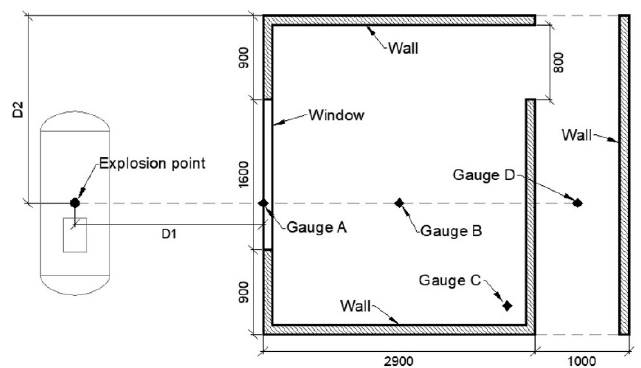
Figure 4. Floor plan for models 3 to 7 (All dimensions are in millimeters)